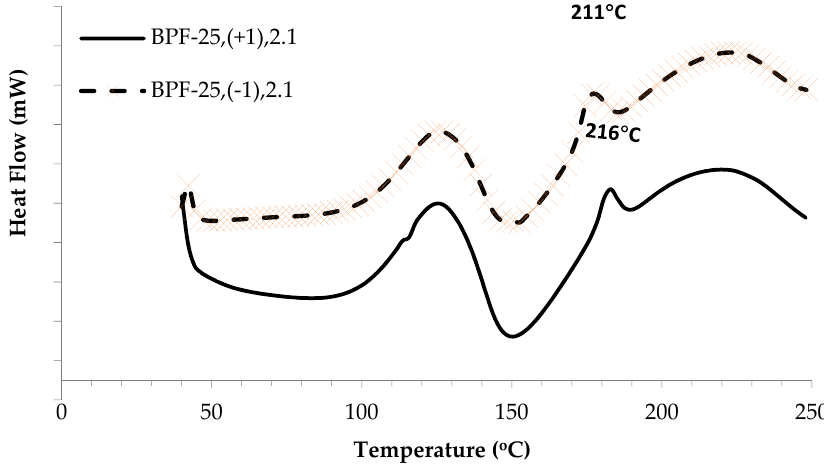
Figure 3. Effects of lignin molecular weight on curing temperature of the BPF Resins at 25% phenol substitution.